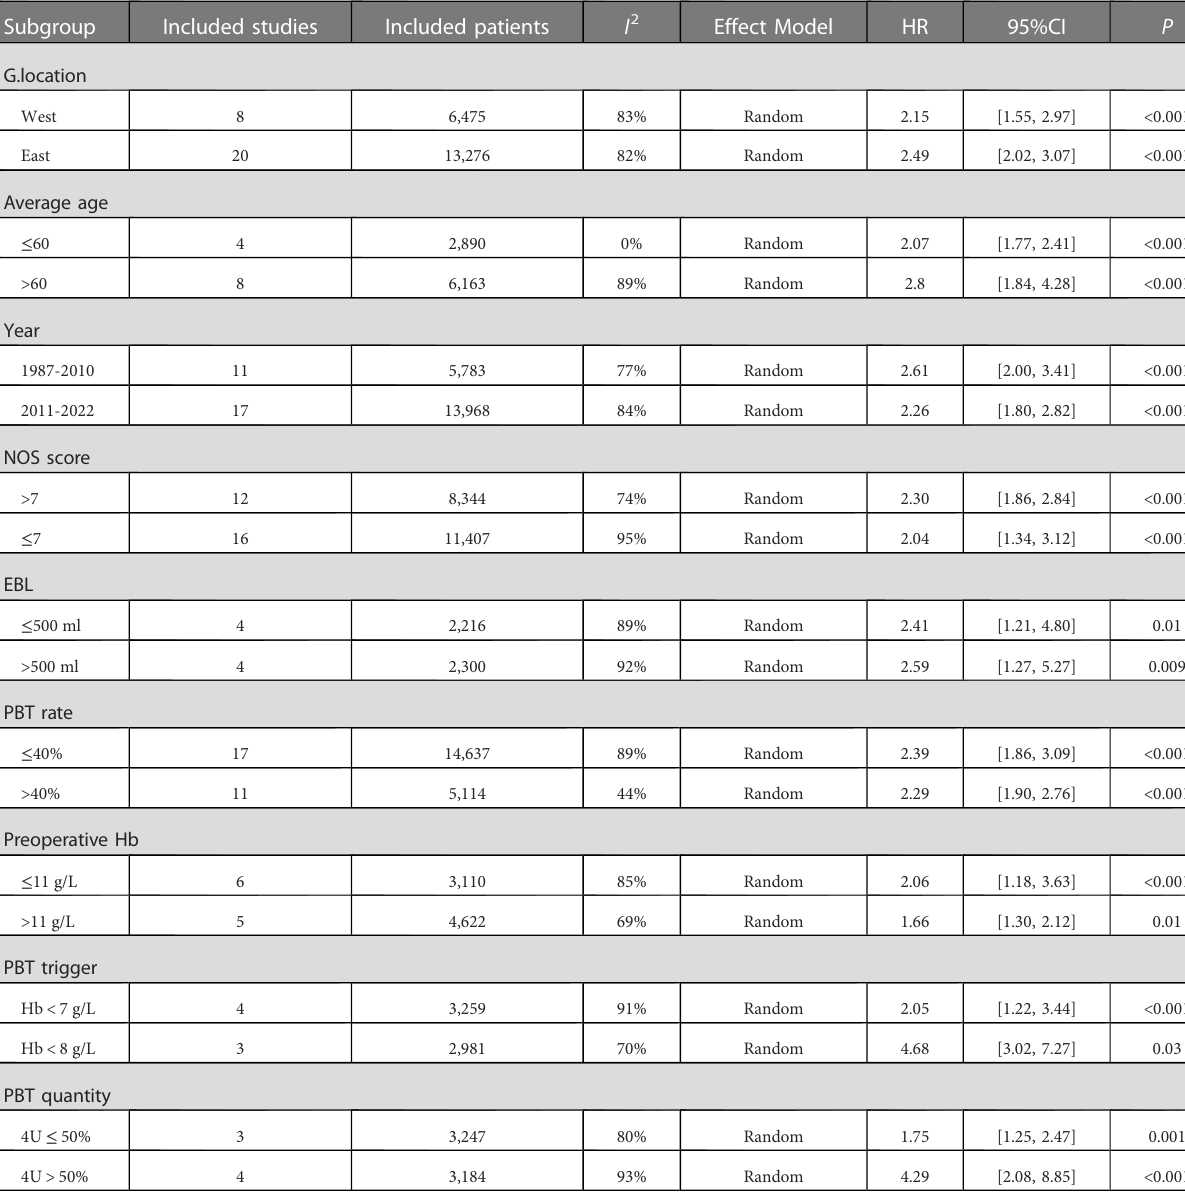
TABLE 3 Strati fi ed meta-analysis of overall survival comparison between the PBT group and NPBT group.